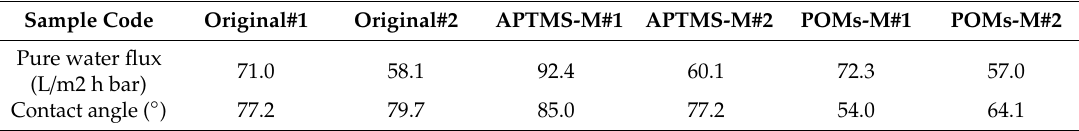
Table 1. Comparison of the POMs-M with APTMS-M membrane in terms of the contact angle and pure water permeation (PWP).